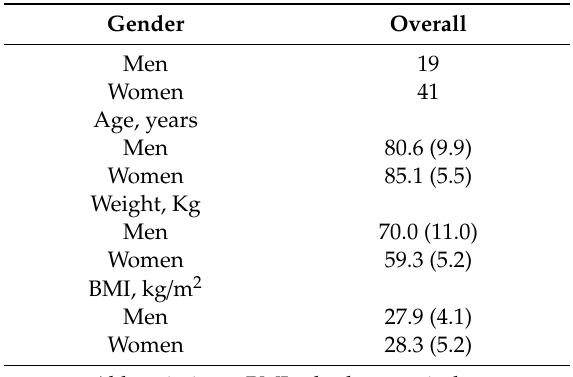
Table 1. Baseline characteristics of the study population ( n = 60) 1